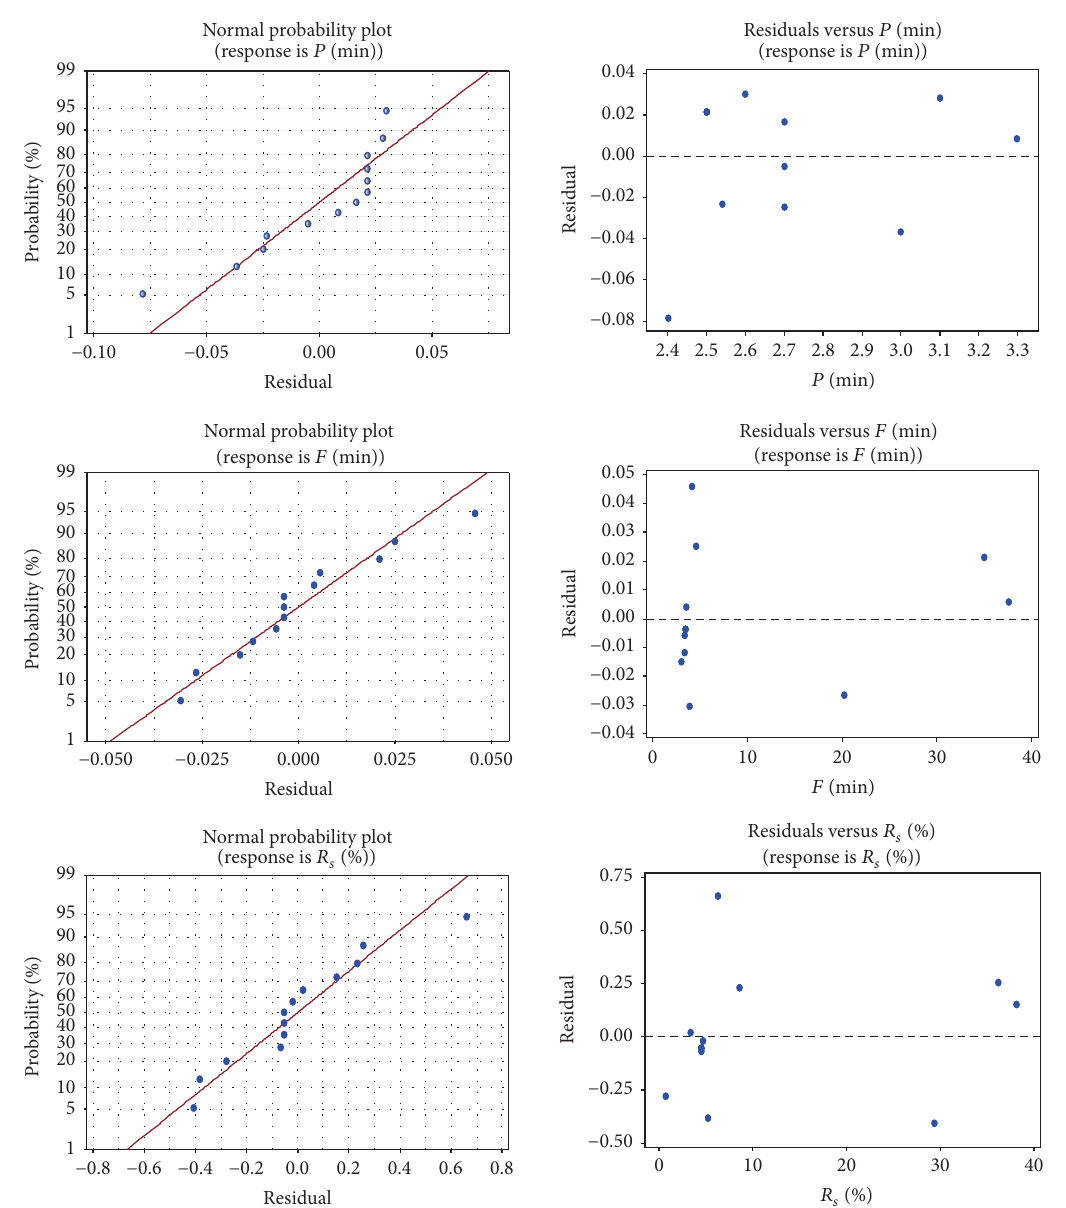
Figure 1: Normal probability plots of residuals and the factor versus residual plots of the proposed quadratic model.